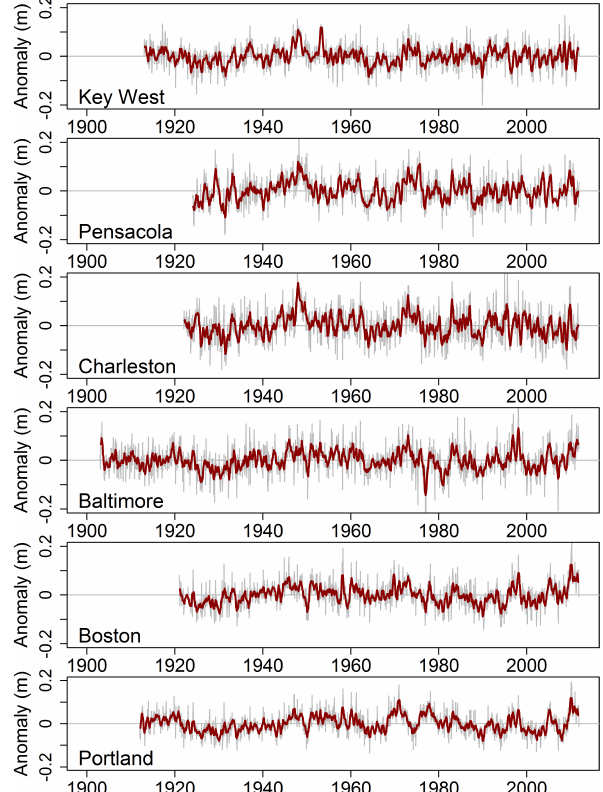
Fig. 6. Interannual variation of monthly mean sea level (gray line) at six long-term tidal stations along the east coast of the United States. The average seasonal cycle and linear sea level trend have been removed. A six month moving average is shown with the thick line. The horizontal axis is the calendar